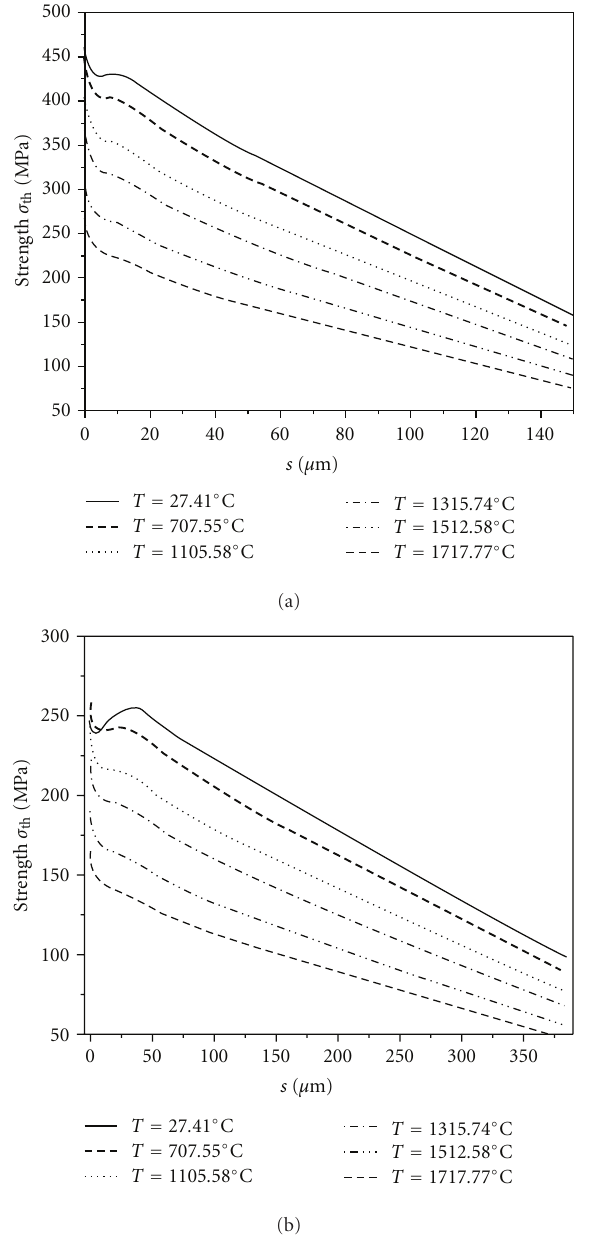
Figure 2: (a) Crack size s dependence of the strength of TiC-20 vol. % SiC at di ff erent temperatures ( R = 15 μ m). (b) Crack size s dependence of the strength of TiC-20 vol. % SiC at di ff erent temperatures ( R = 38 . 5 μ m).